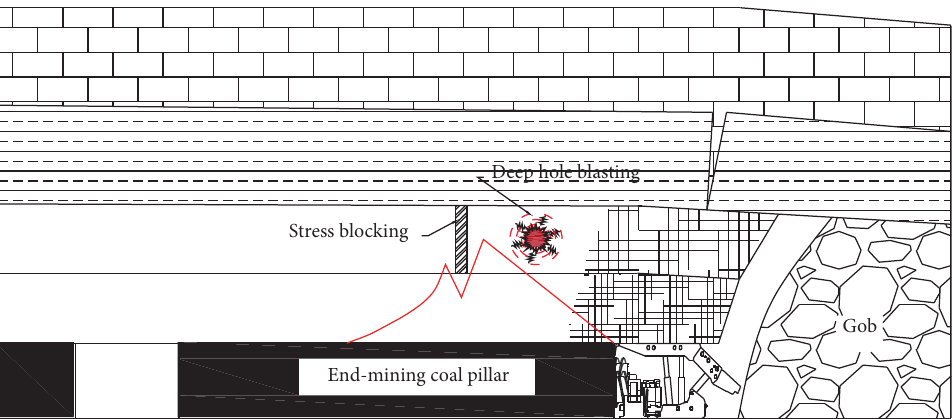
Figure 3: Schematic diagram of stress blocking and blasting